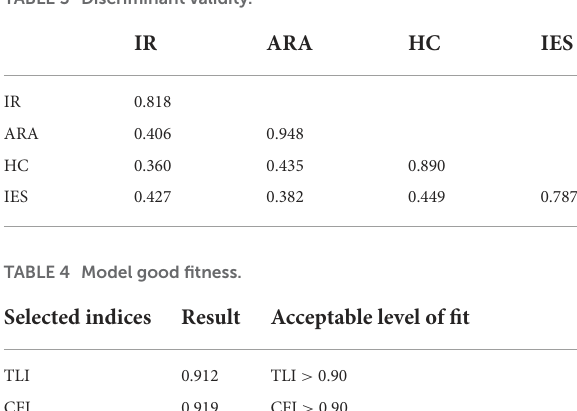
TABLE 3 Discriminant validity.